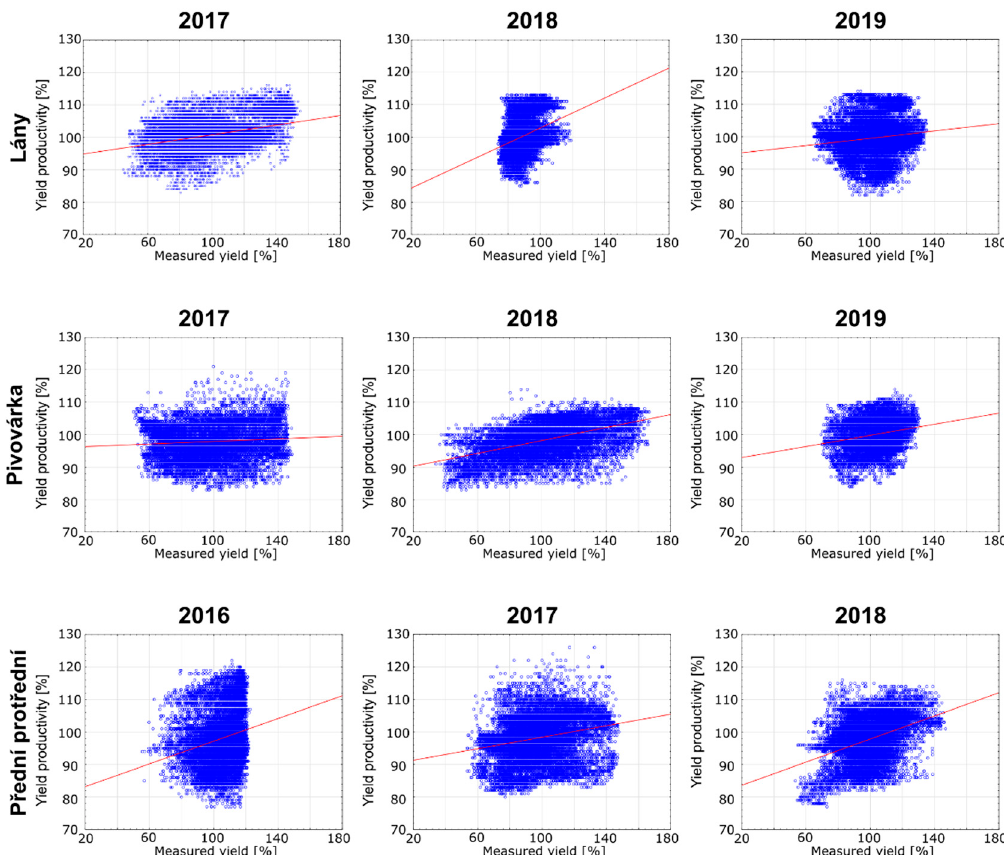
Figure 6. Scatter plots showing the relationships between the yield productivity zones and the measured measured yield.